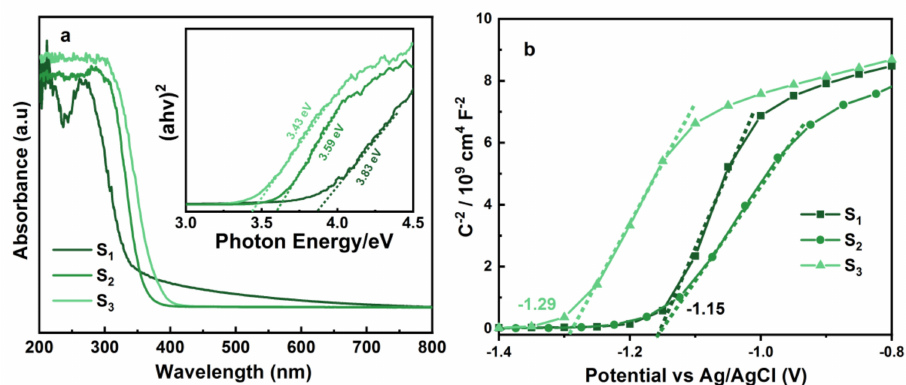
Figure 1. ( a ) UV − _vis absorption spectra; ( b ) Mott − Schottky plots of the samples; Inset of ( a ): the corresponding Tauc’s